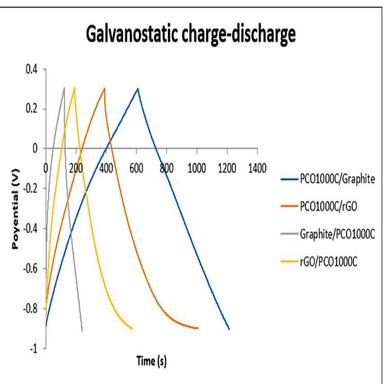
Galvanostatic charge-discharge in H2SO4 at 1 M at 0,005 V/s.